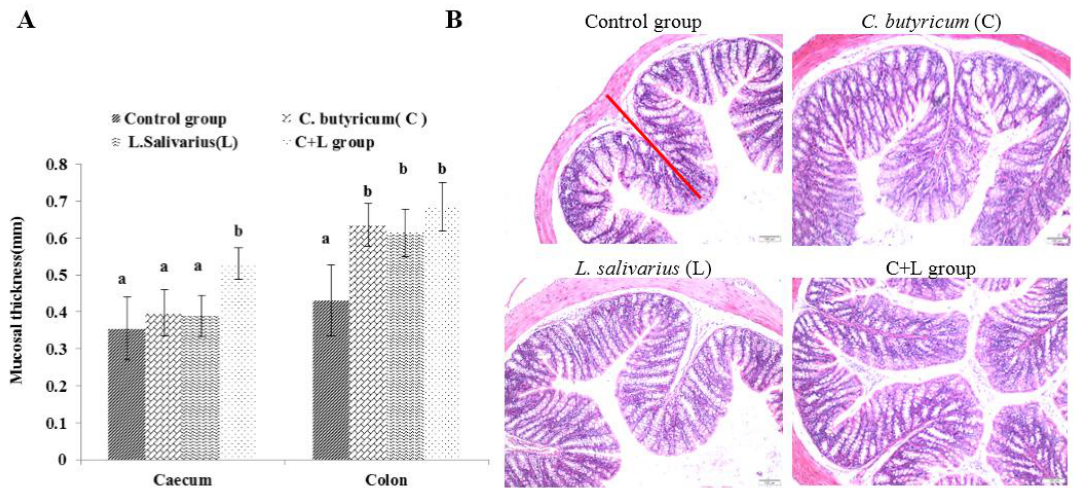
Figure 2. The mucosal thickness of caecum and colon and the colon slice (HE 10 × 10) in different groups. ( A ) The mucosal thicknessm; ( B ) the ileum slice (HE 10 × 10) in control group, L. salivarius group, C. butyricum group and combined treatment group. Red line represents mucosal thickness. Note: On the column of different letters differed significantly ( p < 0.05), without superscript or marked with the same letter angle has no significant difference ( p > 0.05).